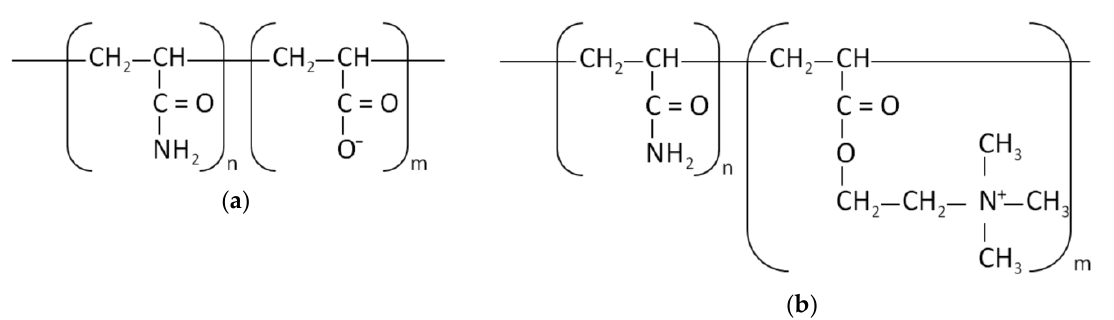
Figure 2. The monomer structure of anionic polyacrylamide ( a ) and cationic one ( b ).